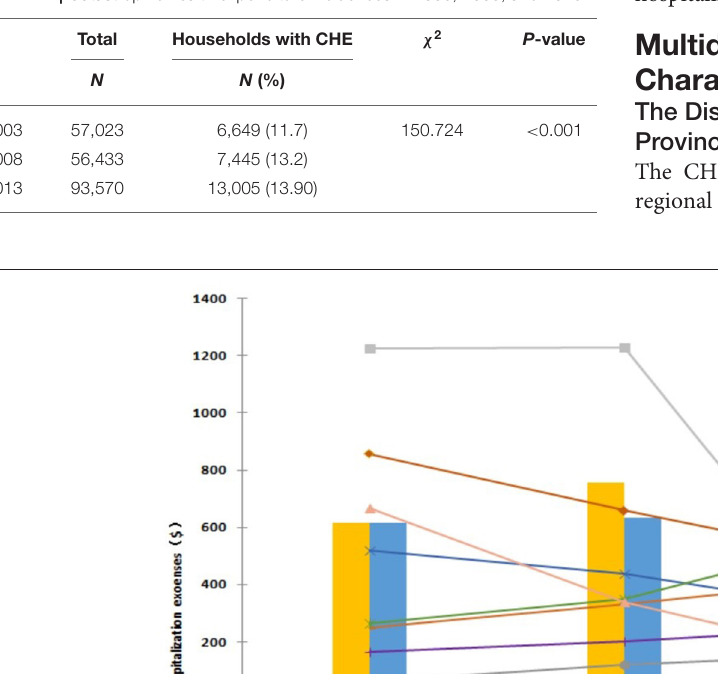
Frontiers in Public Health |